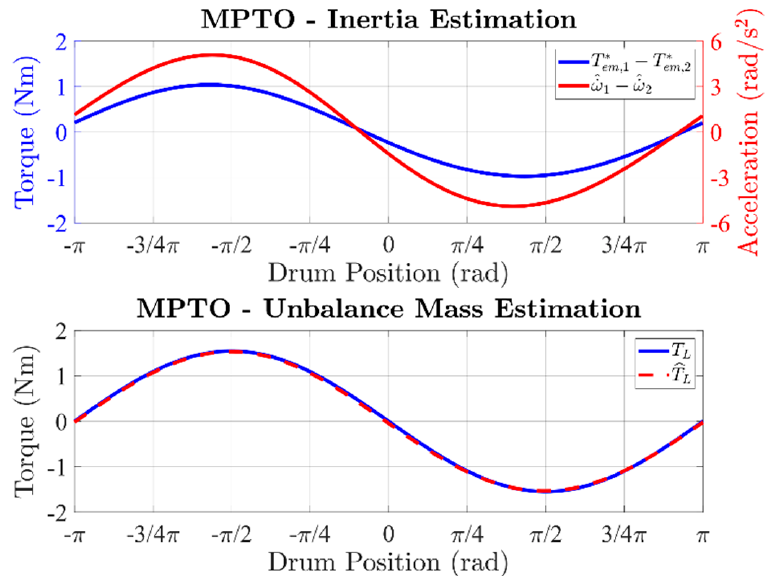
Figure 17. Simulation results. Top: profiles of the numerator and denominator of (9) in one drum revolution for SC1 and SC2. Bottom: profile of the observed and real load torque over one drum revolution at the procedure ends.